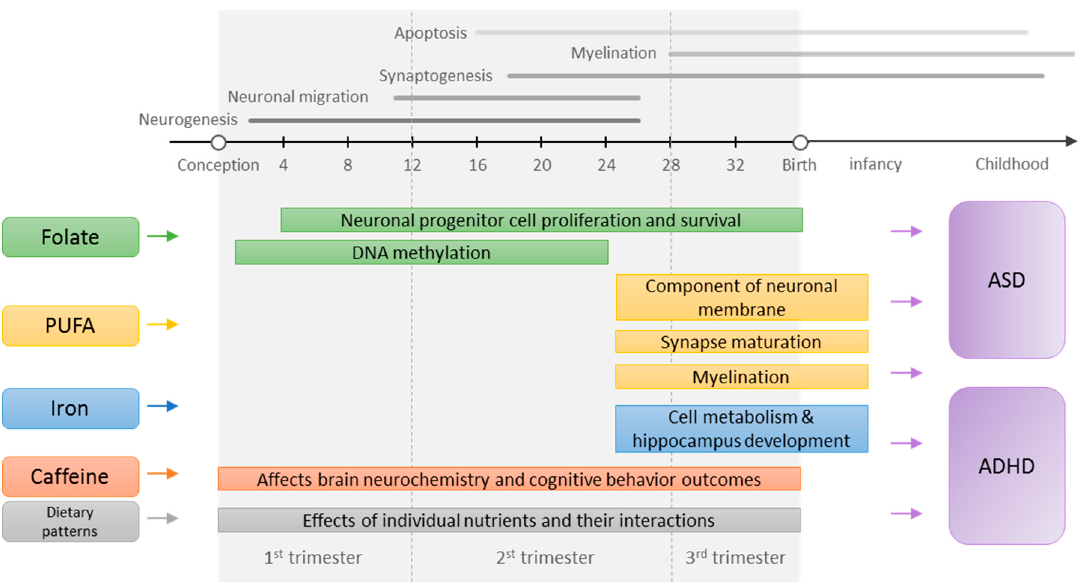
Figure 1. Proposed mechanisms in which preconception and prenatal nutrition affects the risk of autism spectrum disorder (ASD) and attention-deficit/hyperactivity disorder (ADHD). The neurodevelopmental timelines were adapted from the previous publications [3,28] . PUFA, polyunsaturated fatty acids.